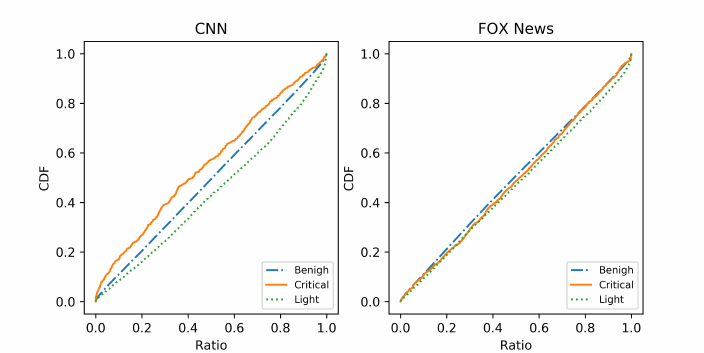
Figure 5. CDFs of different categories occurrences plotted against life stages of targeted